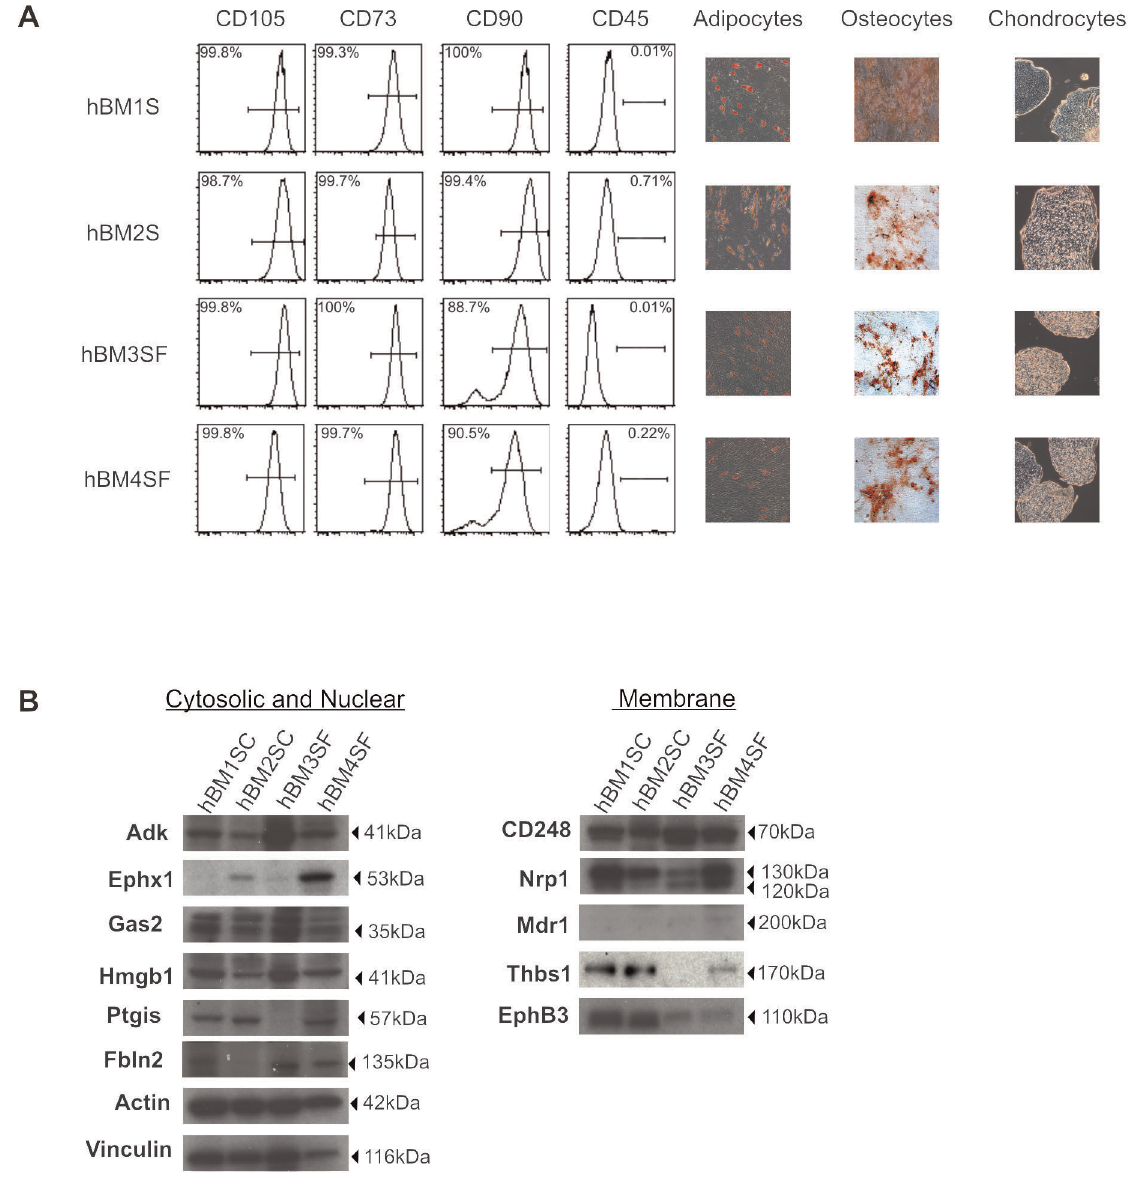
Figure 4. Standard and serum free human stromal cultures containing MSC, harbour cells that express candidate markers of murine MSC at varying quantities. Human bone marrow derived stromal cultures were initiated from 4 different donors in either serum containing (SC) or serum free (SF) conditions. (A) Human stromal cultures containing MSC can be derived in the either SC or SF media. Cultures were analyzed after first passage by both flow cytometry and in multipotent differentiation assays according to ISCT established criteria for MSC. Gates established based on unstained controls were used to compare the frequency of CD105, CD73, CD90 and CD45 expressing cells. Evidence of adipocyte, osteocyte and chondrocyte differentiation from each culture was verified by Oil Red O, Alizarin Red and Alcian Blue staining respectively (n=4). (B) Extracts from human MSC containing stromal cultures express murine MSC specific proteins at frequencies that vary according to both donor and culture condition. An equal quantity of whole cell protein extracts was analyzed by Western Blotting for the presence of murine MSC associated proteins. The molecular weight of each protein is shown at the right of each blot. Nrp1 antibody recognized both modified (130 kDa) and unmodified (120 kDa) forms. Individual blots were analyzed for either actin or vinculin as a control for protein